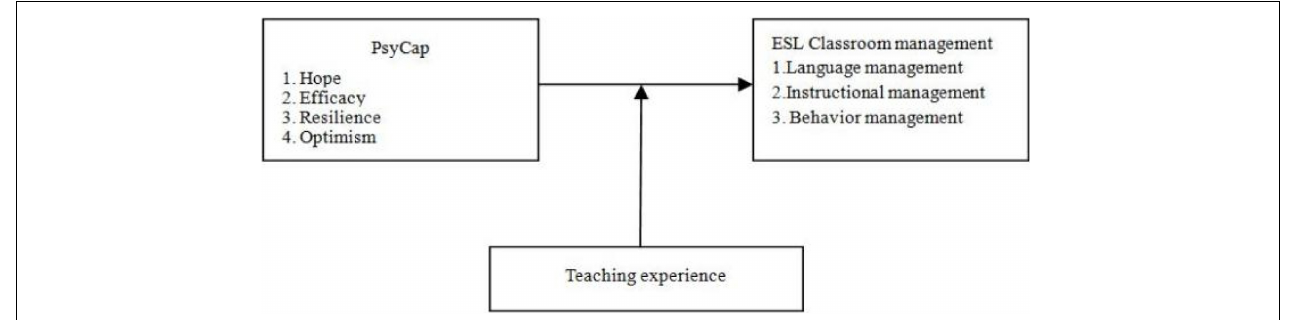
FIGURE 1 | Conceptual